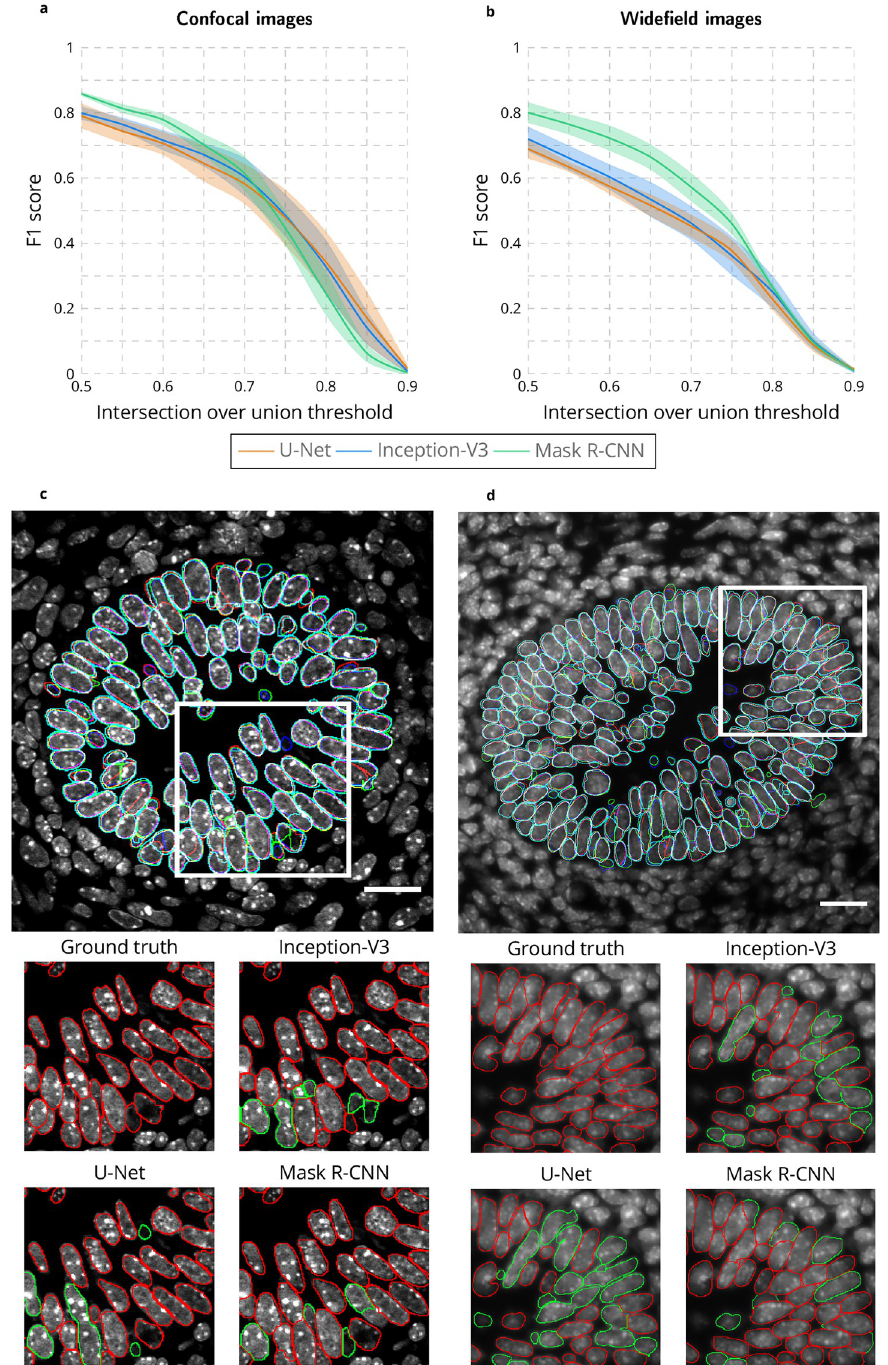
Fig 1. Comparison of U-Net, Inception-V3 and Mask R-CNN for nuclear segmentation. a-b F1 score for range of IoU thresholds obtained with the U-Net, Inception-V3 and Mask R-CNN approaches for confocal a and widefield b images. Lines correspond to average F1 score over the three tested images while the shaded areas represent the standard error. c-d Segmented nuclei obtained with the U-Net (blue), Inception-V3 (green) and Mask R-CNN (cyan) as well as the ground truth (red) for confocal c and widefield d images. White inset rectangles in top images are shown at higher magnification below for the ground truth and each approach. In high-mag images, correctly identified nuclei are outlined in red, incorrectly in green. Scale bar = 20 μ